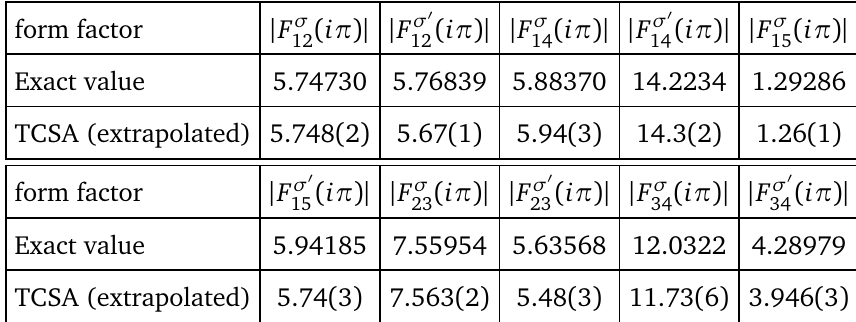
Table 6.2: Crossed two-particle form factors compared to TCSA. The digits in paren- theses indicate the error in the last digit of the TCSA data, which is estimated from the stability of the exponential fit under the choice of the volume window. Note that the deviations in the subleading magnetisation data are an order of magnitude worse then for the leading one, and also that TCSA estimates of matrix elements involving higher particles are generally less accurate due to truncation errors, as discussed in Appendix C.2. In particular, the apparent large deviation in the entries F σ (cid:48) ( i π ) is due to both one-particle states being high in the spectrum, which makes F σ 34 the determination of the corresponding wave functions less